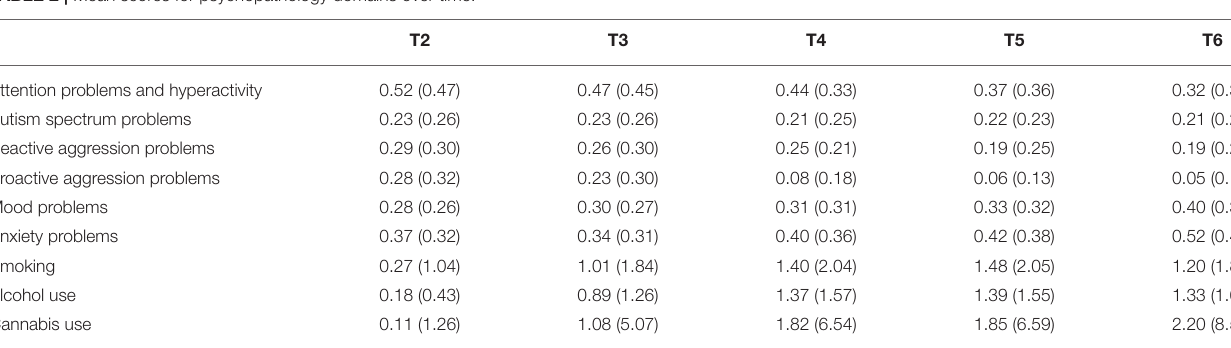
TABLE 2 | Mean scores for psychopathology domains over